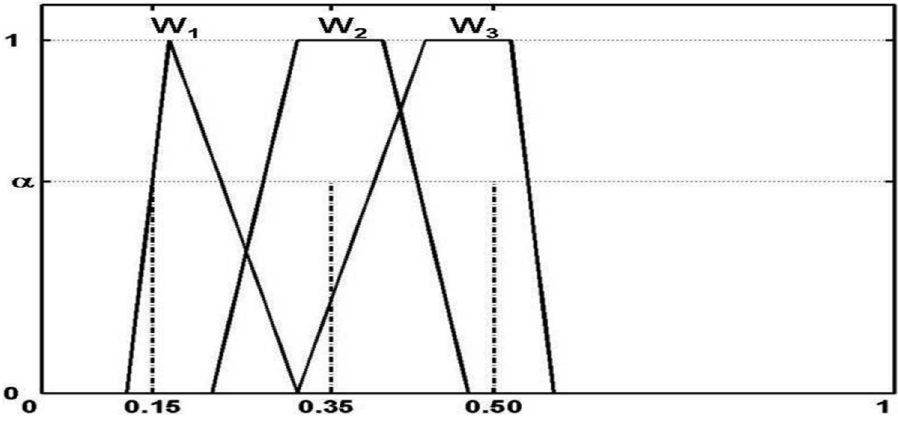
Figure 8. An example of normalized fuzzy